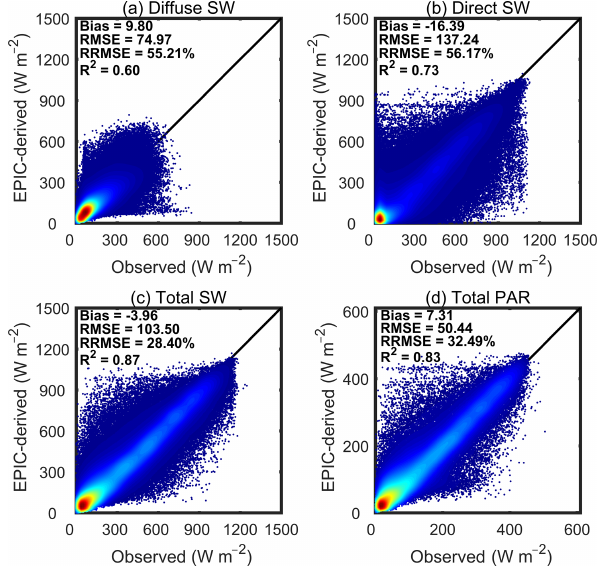
Figure 2. Evaluation of EPIC-based hourly SW–PAR estimates against ground-based observations.